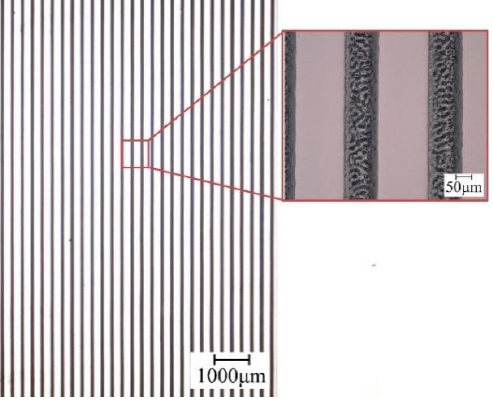
Figure 8. Schematic diagram of trapezoidal groove structure (×20).